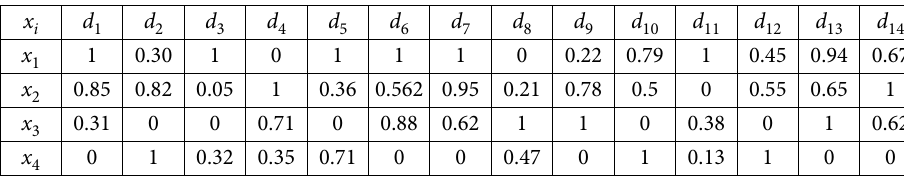
Table 6. The normalized evaluation